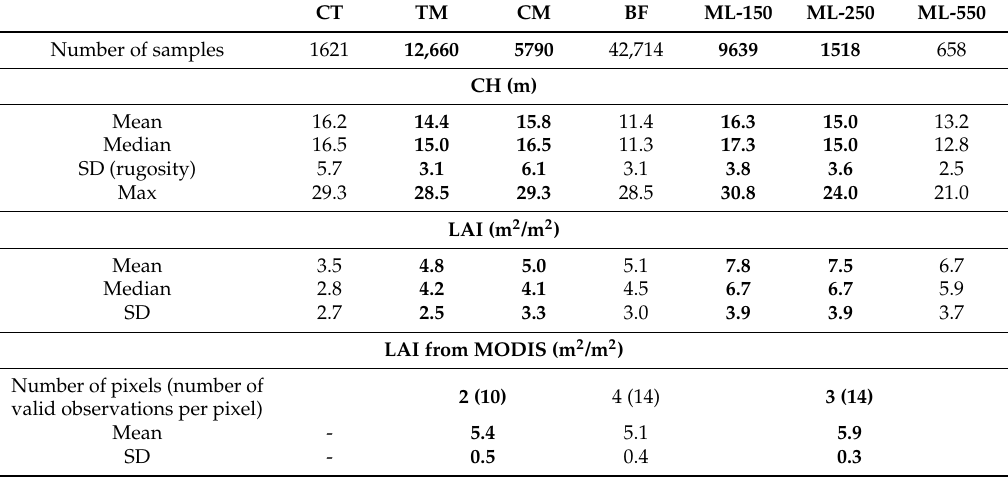
Table 3. Statistics (mean, median and standard deviation (SD)) for both the canopy height (CH) and the assessment of the LAI on the 7 sites: coastal (CT), Tamarind (TM), Cryptomeria (CM), Bélouve (BF) and Mare-Longue (ML-150, -250 and -550) sites. Profiles with CH < 5 m are not considered. Bold characters highlight the 4 forest sites where in situ measurements are available (see Table 1). The maximal CH derived from the LiDAR is also